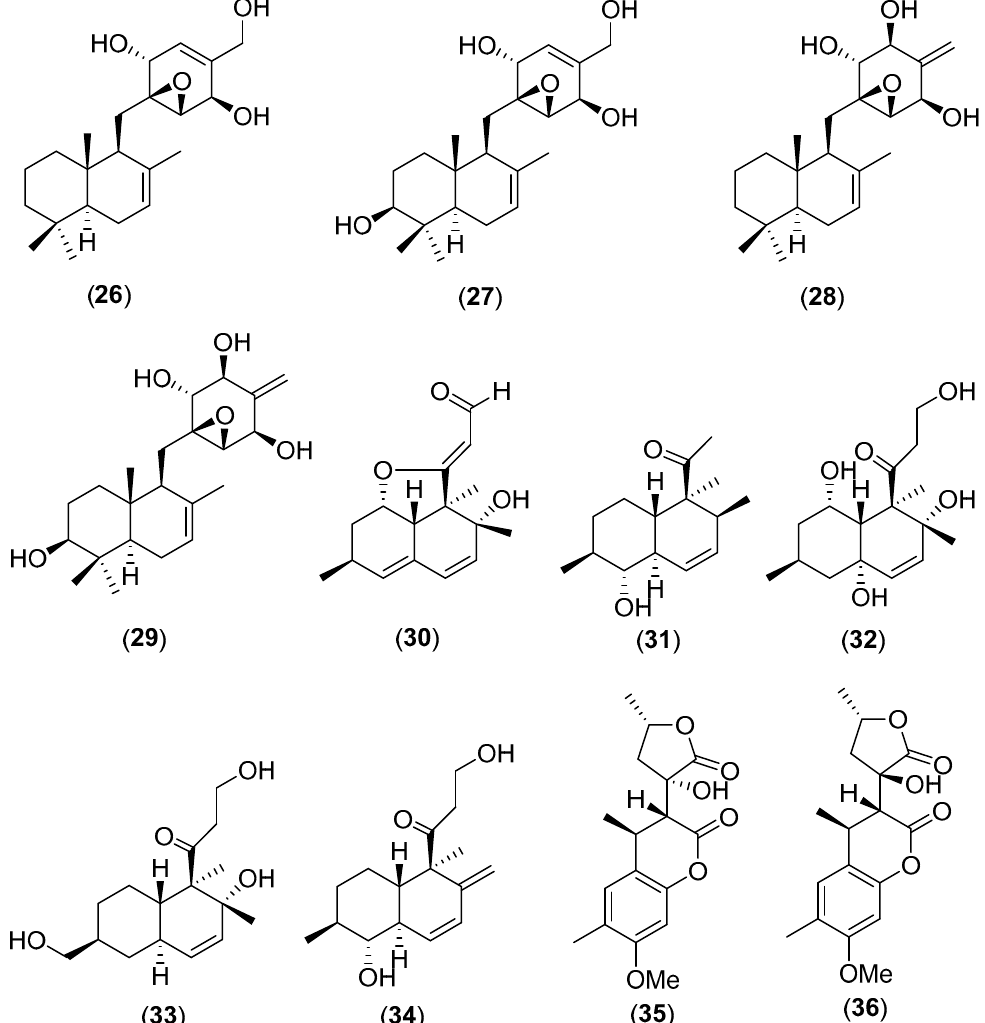
Figure 6. Chemical structures of selected compounds isolated from Craterellus odoratus.